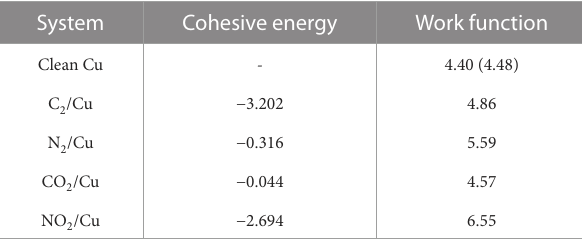
TABLE2 CalculatedcohesiveenergiesΔH coh (eV/molecule),andcalculated workfunctions φ (eV)forcleanCu(110).Theexperimentalworkfunctionfor cleanCu(110)isprovidedinparenthesesandisfromReference (Gartland et